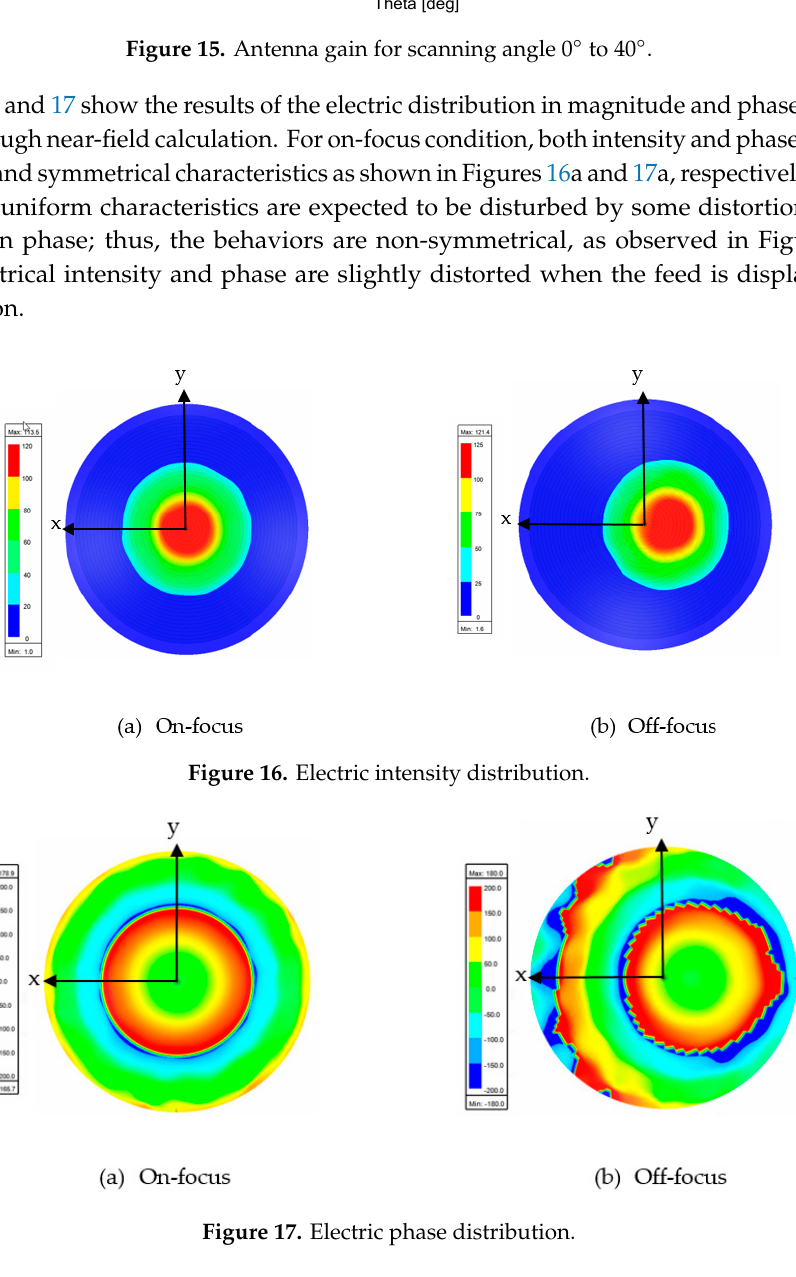
Figure 17. Electric phase distribution.